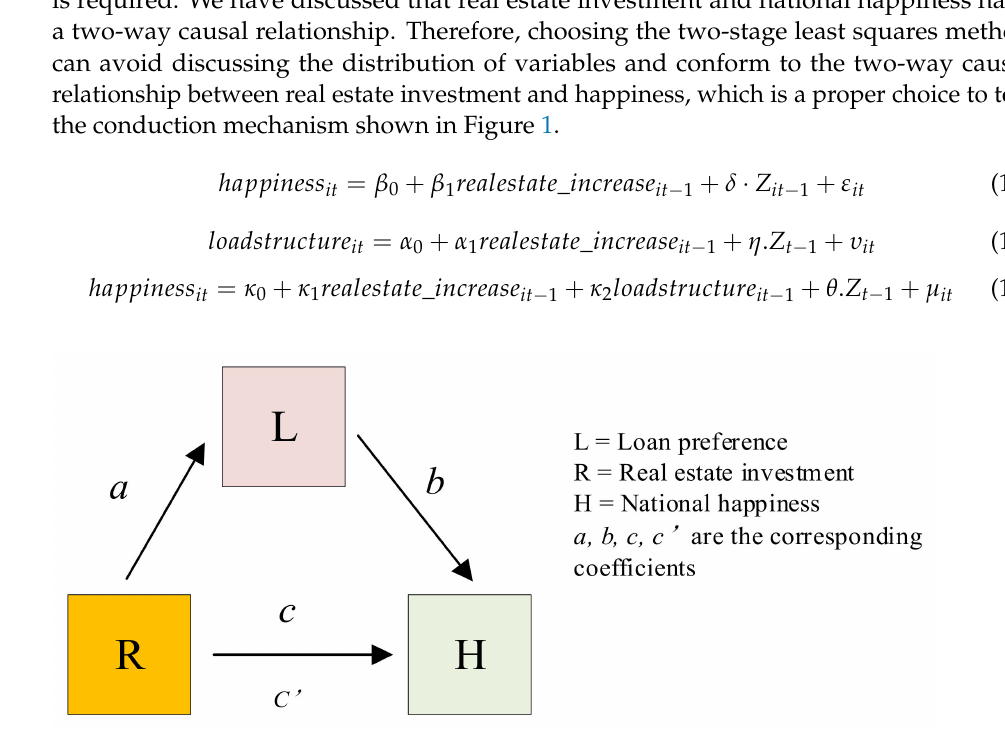
Figure 1. Real estate growth, loan preference, and national